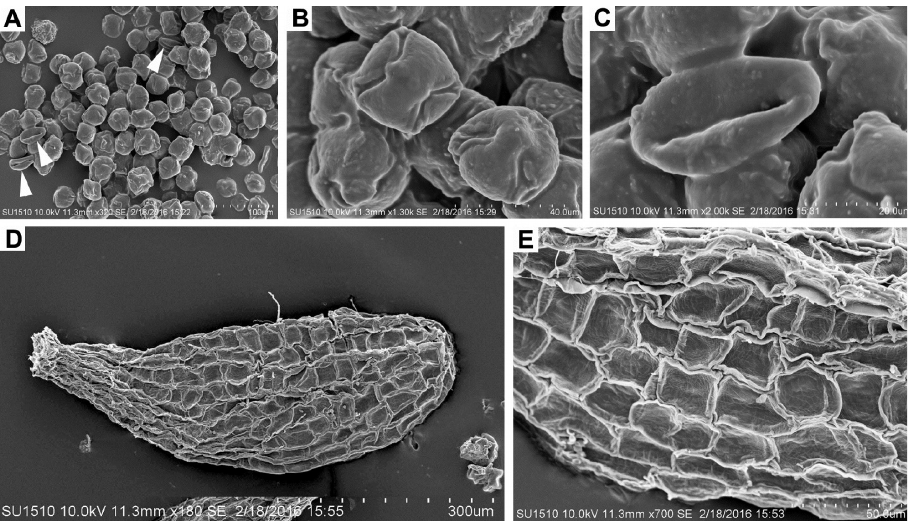
Figure 2. Scanning electron microscopy of E. coruana , pollen and seed ( García & García 9138 ). A–C Heteromorphic pollen grains; arrows indicate a few 3-colpate, prolate pollen grains B 4-colpate (left, upper) and 3-colpate pollen (right, down) grains C 3-colpate, prolate pollen grain D–E Seed mor-